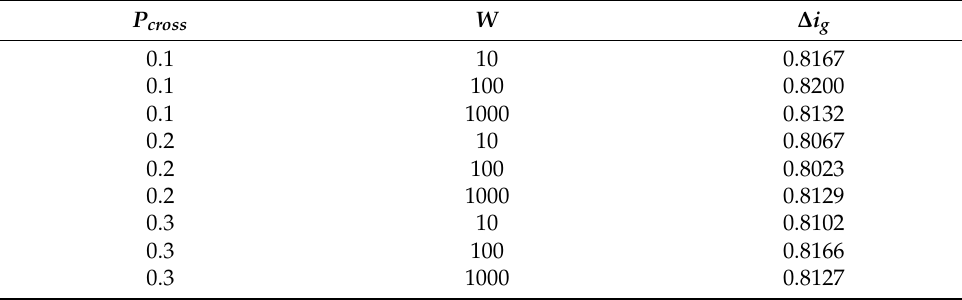
Table 2. Obtained results from the sensitivity test considering G =